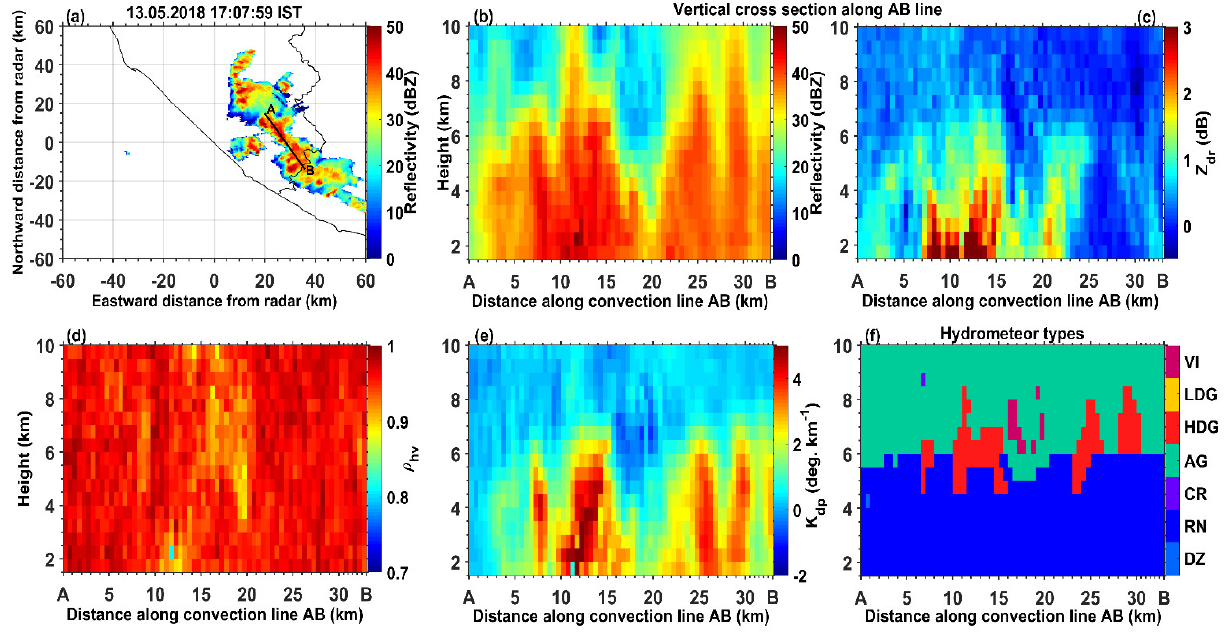
Figure 11. ( a ) Radar reflectivity averaged between 2.5 and 3.5 km height on 13 May 2018. Vertical cross section of ( b ) reflectivity, ( c ) Z dr , ( d ) ρ hv , ( e ) K dp and ( f ) identified hydrometeor types along AB convection line at 17:07:59 IST.